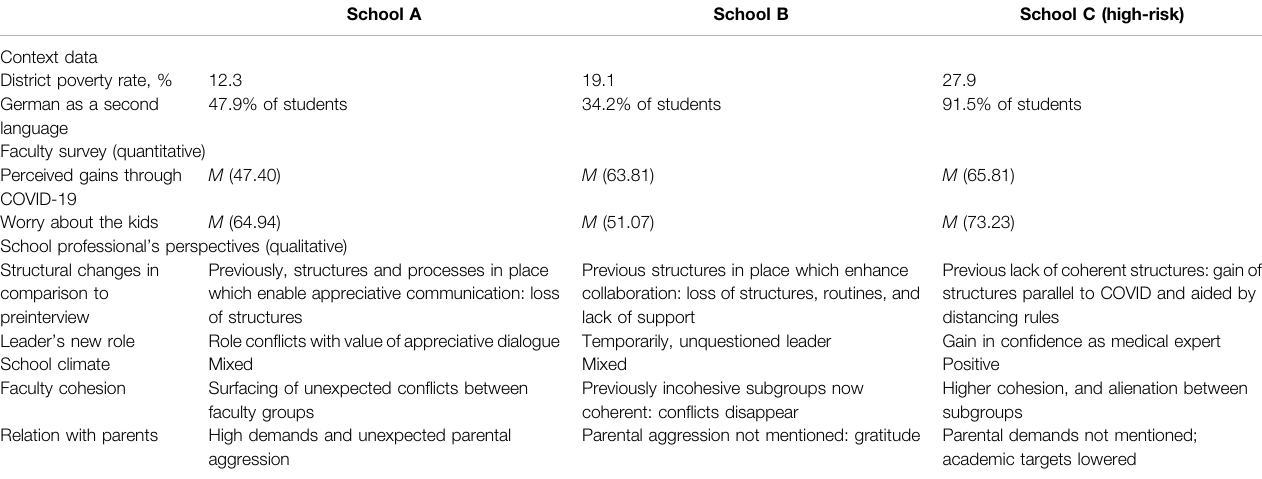
TABLE 1 | Between-school differences in context, survey results, and